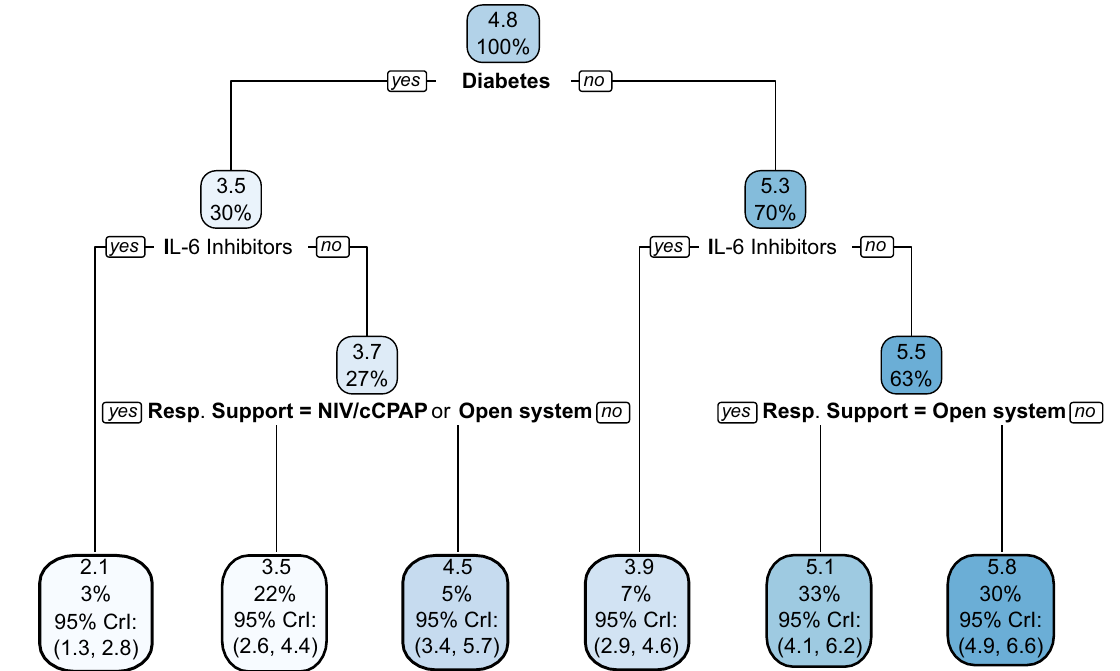
Figure 3. Model results for the continuous outcome days without life support at day 90. The top value in each box is the estimated mean difference in days alive without life support (12 mg/d group minus 6 mg/d group) in the subgroup with corresponding covariate values. The bottom value in each box is the proportion of the trial sample belonging to the subgroup. A complete walk through of the figure is provided in the main text (see results). The first square at the top indicates that the estimated overall mean difference in the trial was 4.8 days in favor of 12 mg/d. Next, for those with diabetes (30% of the sample), the estimated mean difference was 3.5 days, while for those without diabetes (70% of the sample) the estimated mean difference was 5.3 days, both in favor of 12 mg/d. Subsequent splits in the decision tree can be interpreted similarly. Cross validation selected a power prior of 1, a base prior of 0.95, and 400 trees.